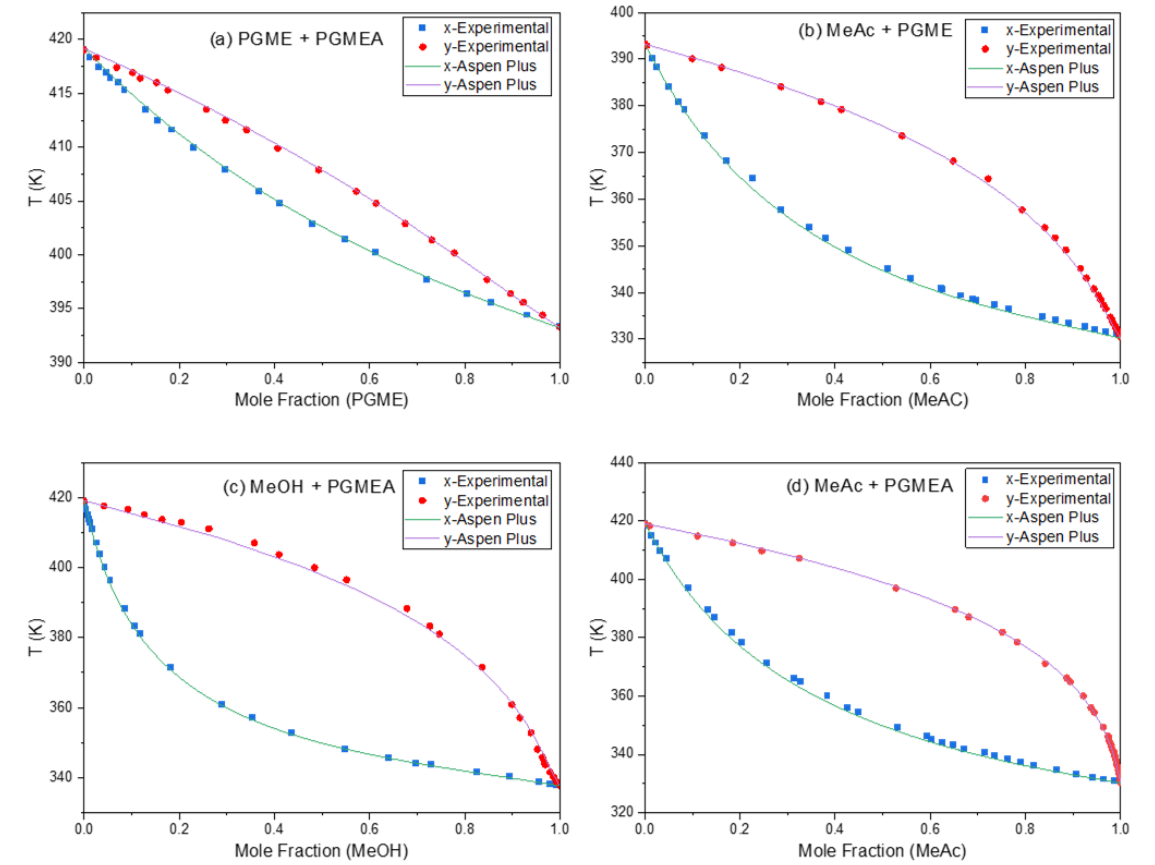
Figure 2. Comparison: T–xy binary diagram between Aspen Plus calculated VLE and experimental data: ( a ) PGME + PGMEA; ( b ) MeAc + PGME; ( c ) MeOH + PGMEA; ( d ) MeAc + PGMEA.